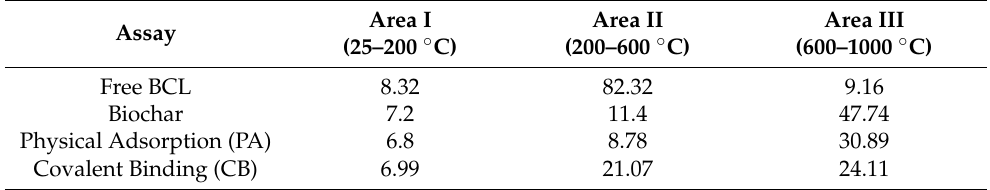
Table 3. Mass loss data (%) by TGA for the free lipase and immobilized biocatalysts.